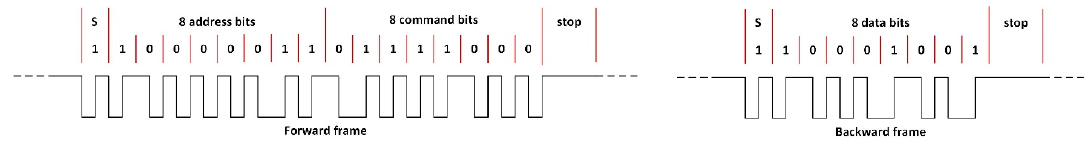
Figure 4. Format of the DALI frames.